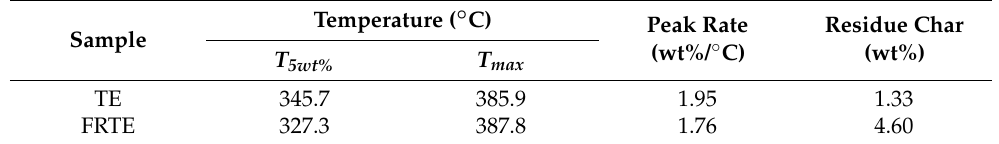
Figure 4. Thermal stability of TE composites. Table 2. TGA data of TE